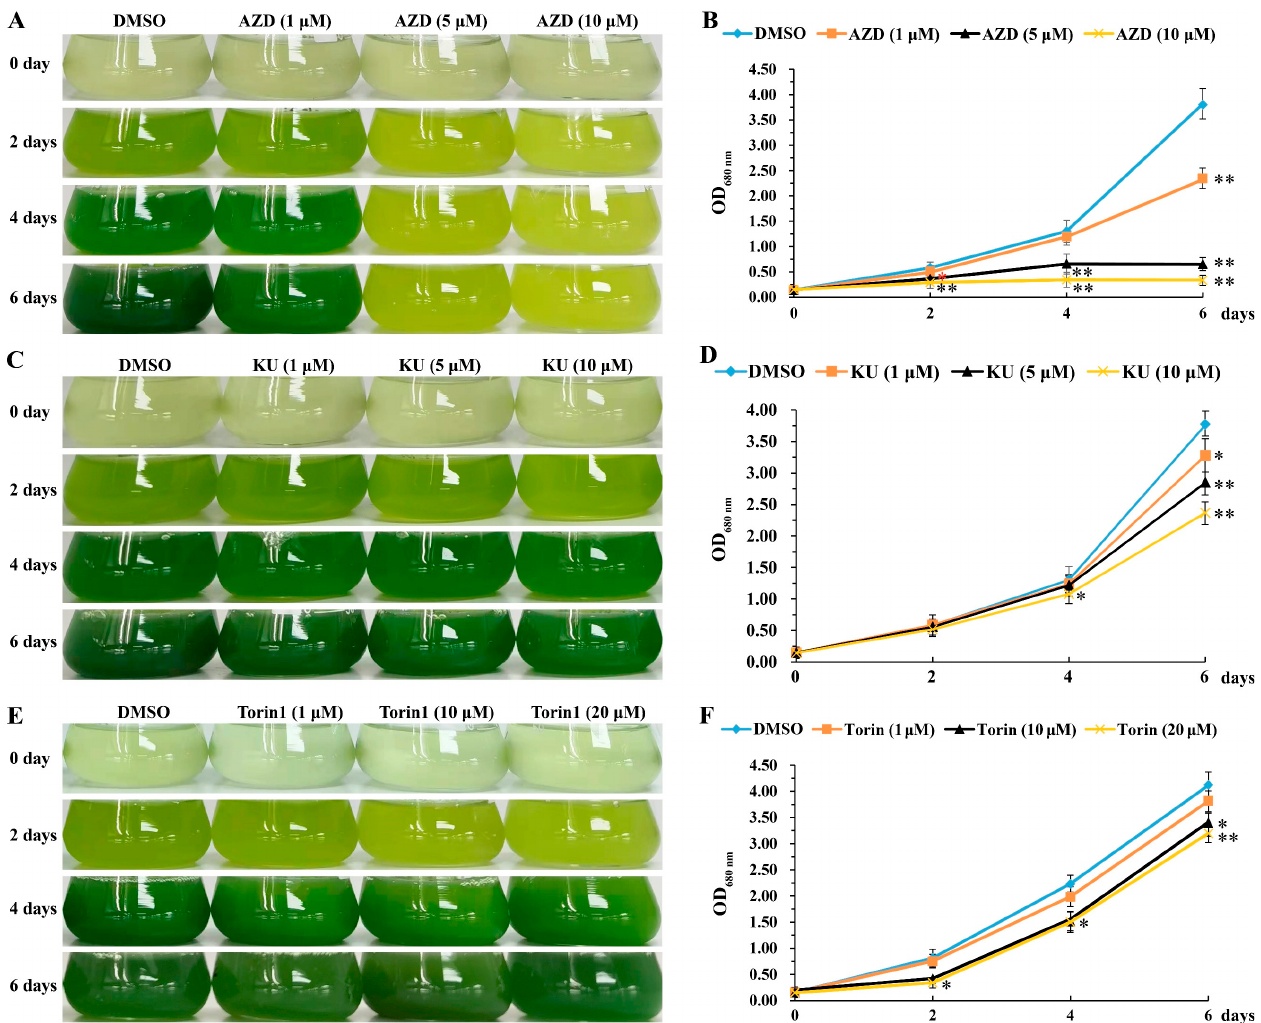
Figure 4. Effects of TOR kinase inhibitors on growth of Chlorella sorokiniana DP-1. ( A ) AZD inhibits the growth of Chlorella sorokiniana DP-1 in a dose-dependent manner. Phenotype of Chlorella sorokiniana DP-1 treated with different concentrations of AZD for 0, 2, 4 and 6 days. ( B ) Change curves of OD680nm values of Chlorella sorokiniana DP-1 treated with 1, 5 and 10 μ M AZD for 0, 2, 4 and 6 days. ( C ) Phenotype of Chlorella sorokiniana DP-1 treated with different concentrations of KU for 0, 2, 4 and 6 days. ( D ) Change curves of OD680nm values of Chlorella sorokiniana DP-1 treated with 1, 5